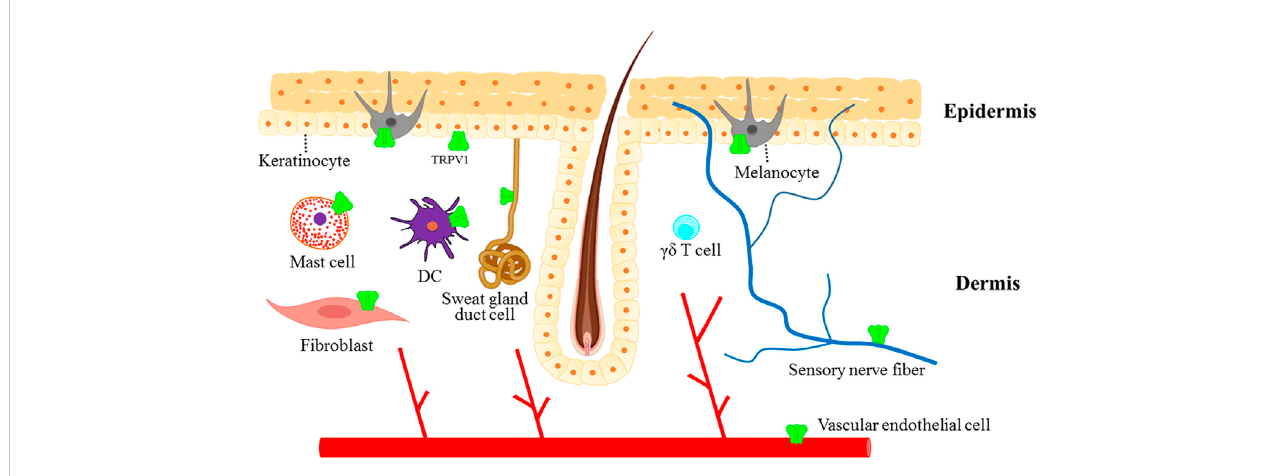
FIGURE 2 The expression of TRPV1 in the skin. TRPV1 channel is not only expressed in sensory nerve fi bers innervating the skin but also in different non-neuronal cells, which contribute to maintaining normal skin physiology or play important roles in the pathogenesis of skin